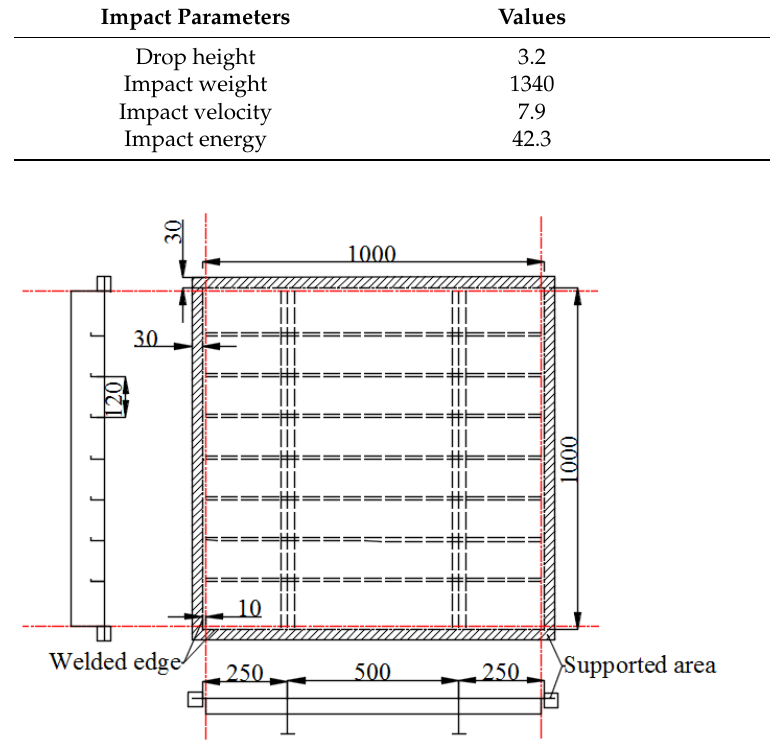
Figure 5. The geometry of the specimen (Scale 1:4, Unit: mm). Table 2. Dimension and thickness of stiffened panel.